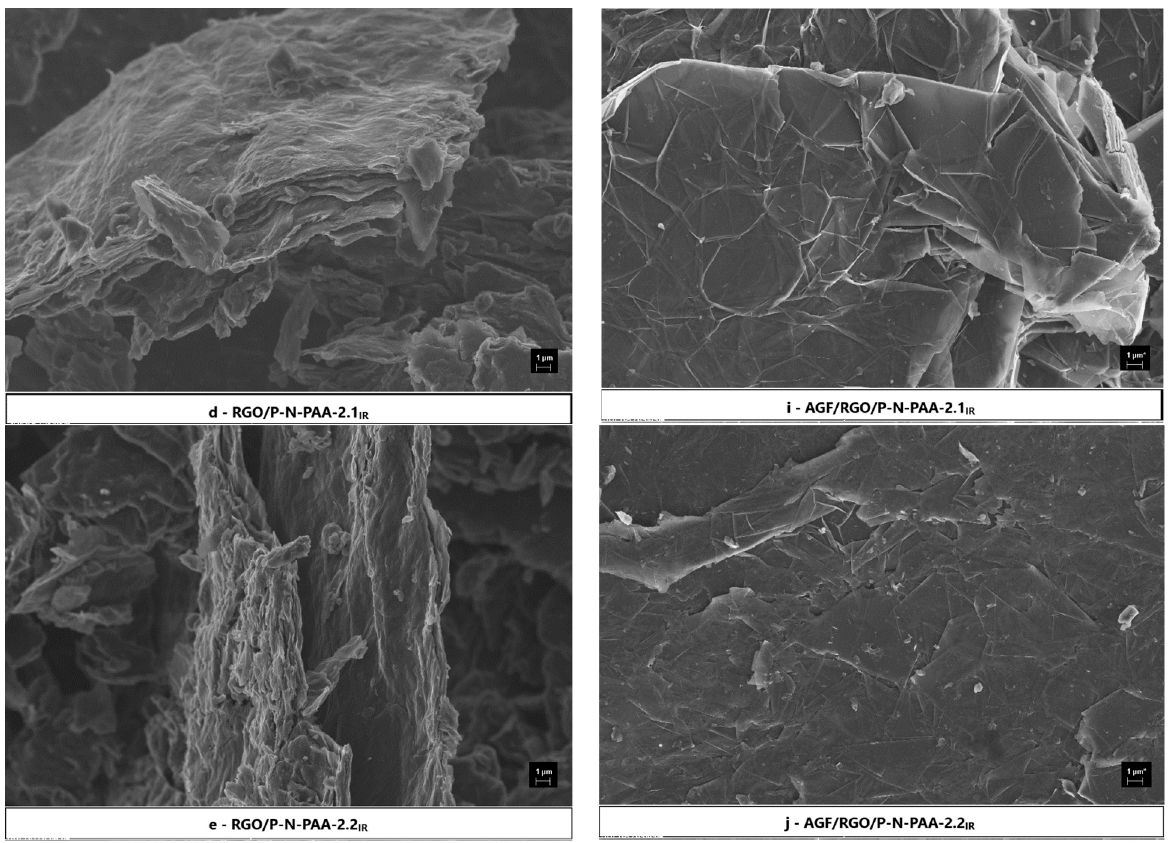
Figure 5. FE-SEM images of RGO/P-N-PAA ( a – e ) and AGF/RGO/P-N-PAA ( f – j ).